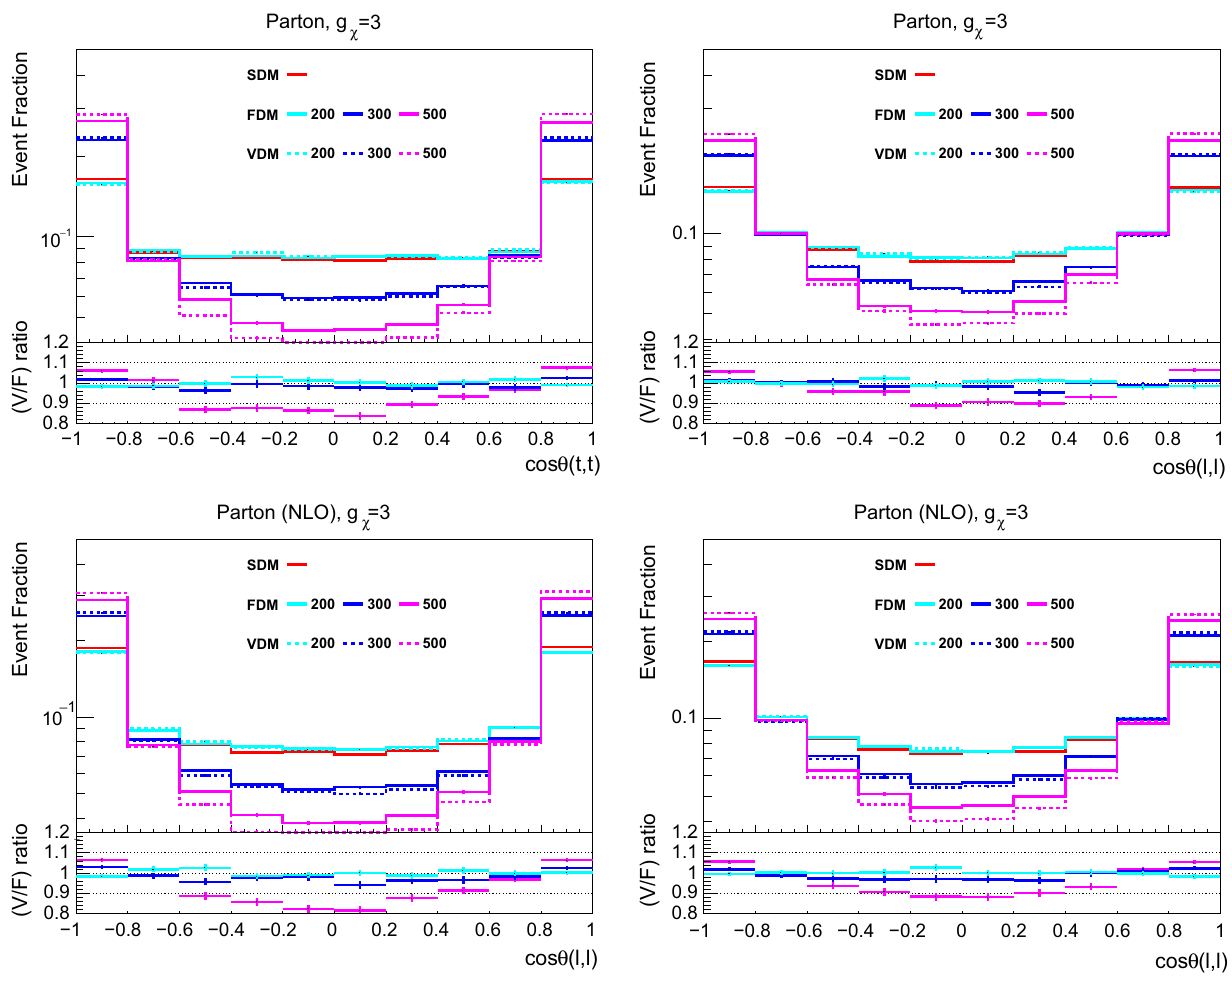
Fig. 3 Distributions of the angular difference between top quark pair (left) and the lepton pair from top quark decay (right) at leading order (upper) and next-to-leading order